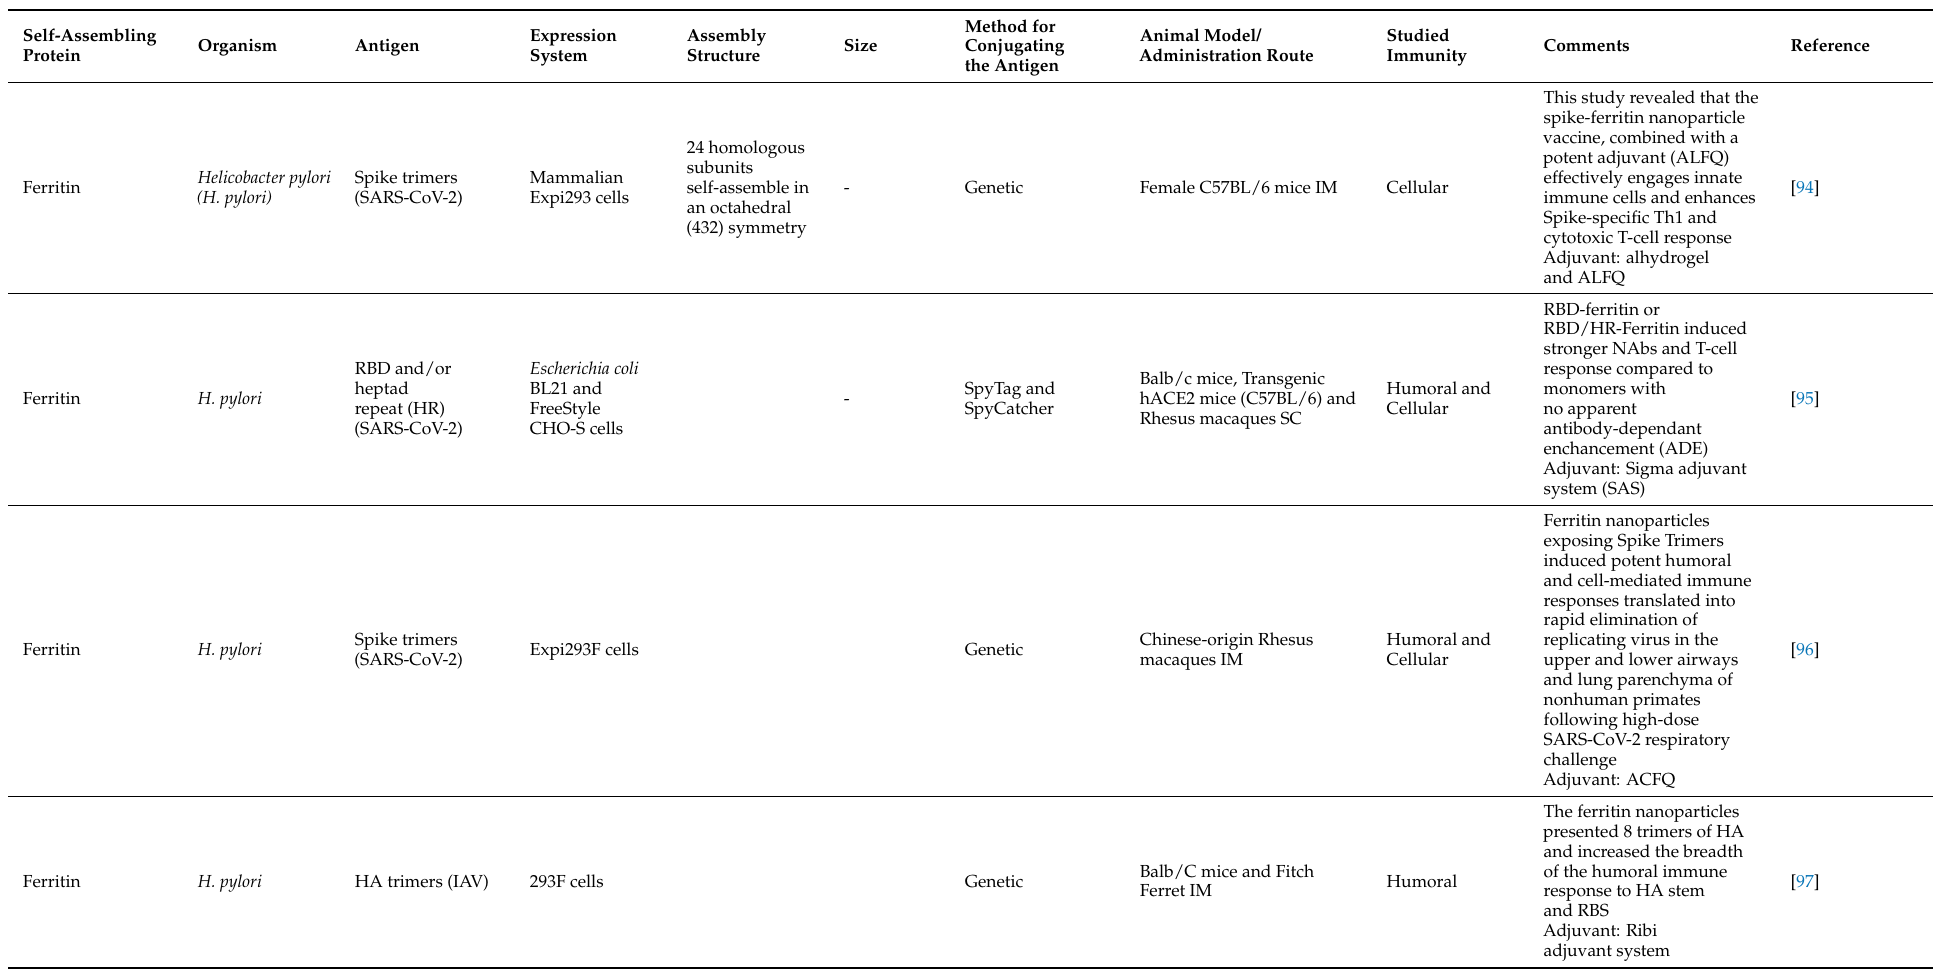
Table 2. Bacterial self-assembling proteins evaluated as nanoscaffolds for antigen delivery in subunit